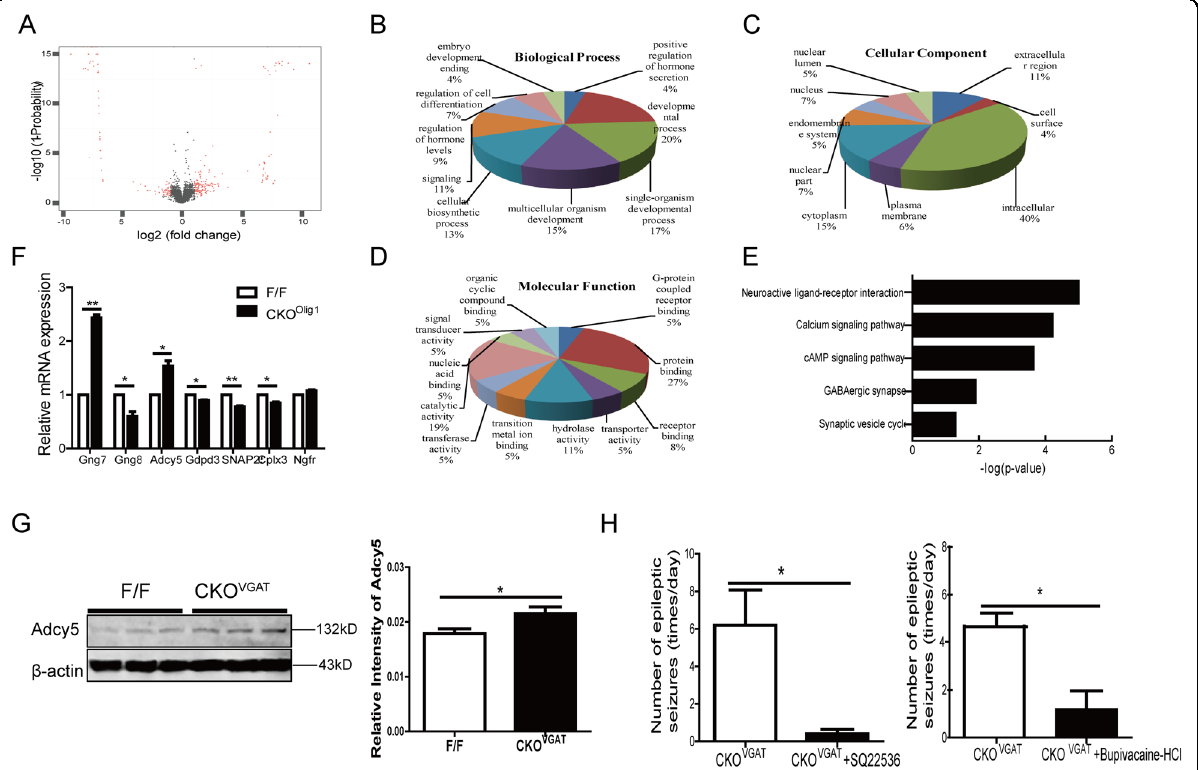
Fig. 5 RNA-seq analysis of the DEGs and signaling pathways between CKO Olig1 and F/F mice. A Volcano plot to visually compare the DEGs between the CKO Olig1 group and the control group. B – D GO analysis of the cellular components, molecular functions and biological processes associated with the DEGs. E KEGG pathways of DEGs between the CKO Olig1 and F/F mice. F qRT-PCR validation of some DEGs. G Western blot analyses demonstrate higher in Adcy5 expression in CKO VGAT mice than in controls. β -actin was used as the internal loading control. Data are mean ± SEM for 3 mice per genotype. H The SQ22536/bupivacaine-HCl (AC/cAMP inhibitor) signi fi cantly reduced the frequency of seizures in CKO VGAT mice ( n = 5 and n = 6). Signi fi cant differences from the control group: * P < 0.05; ** P < 0.01, paired Student ’ s t